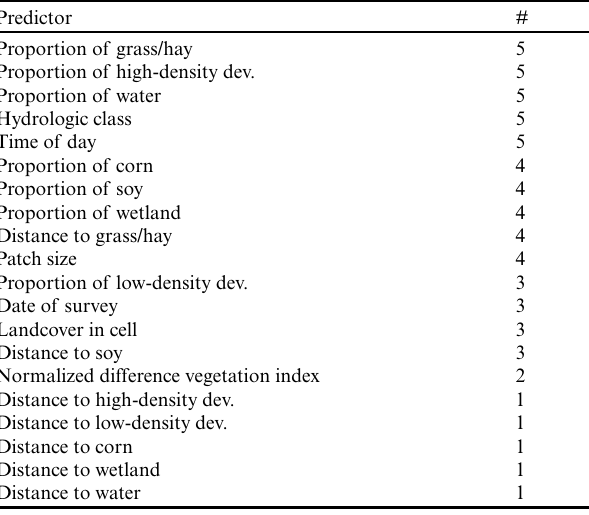
Table 4 . Total ecosystem service value ($2014/ac/year) associated with both protected and unprotected portions of each Grassland Bird Conservation Area